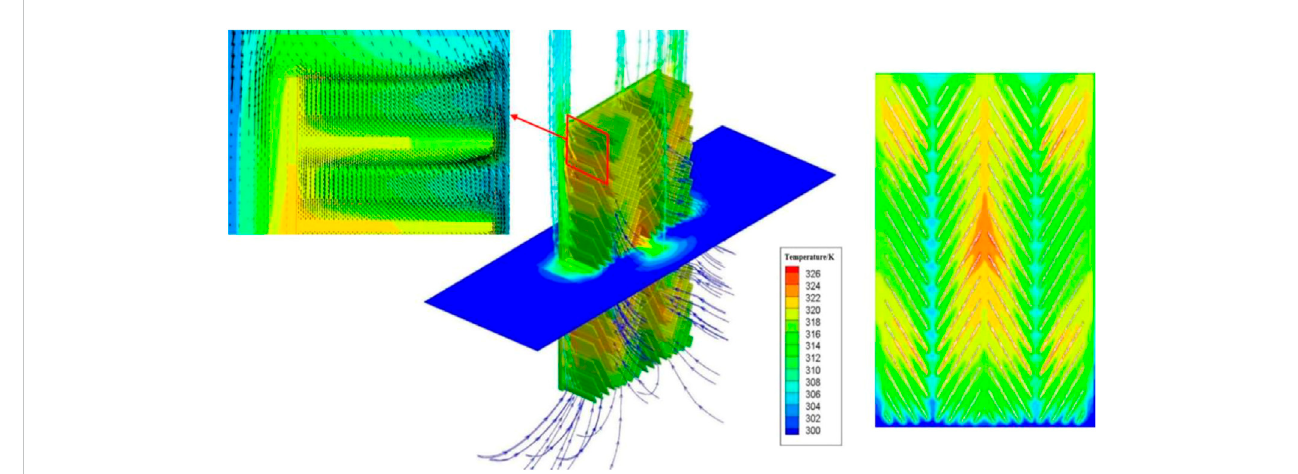
FIGURE 7 The fl ow lines and temperature distribution of the W-shaped heat sinks (Zhang et al.,